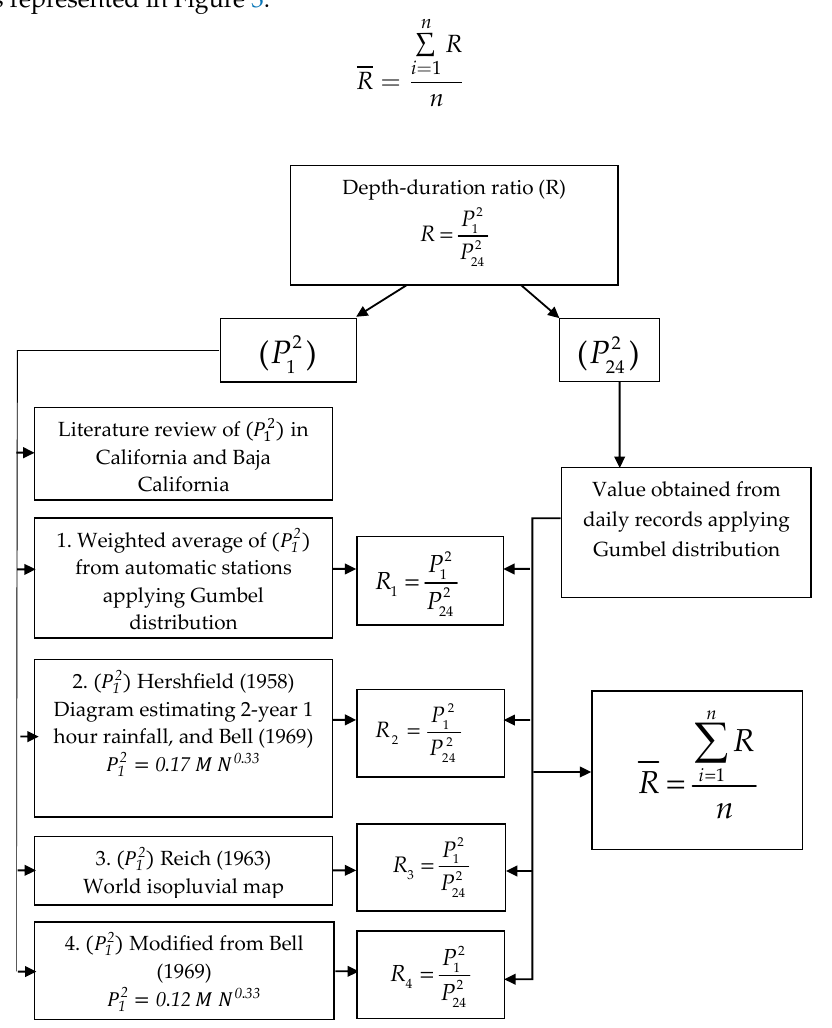
Figure 3. Procedure to determine the ( R ) ratio proposed. R is the average ratio and n is the number of ( R 1 ... 4 ) calculated for each ( P 2 1 ) . Once the ( R ) ratio was determined for each rain gauge station, the spatial distribution of the ( R ) ratio was drawn on a map by interpolation, using the Inverse Distance Weighting (IDW) method.